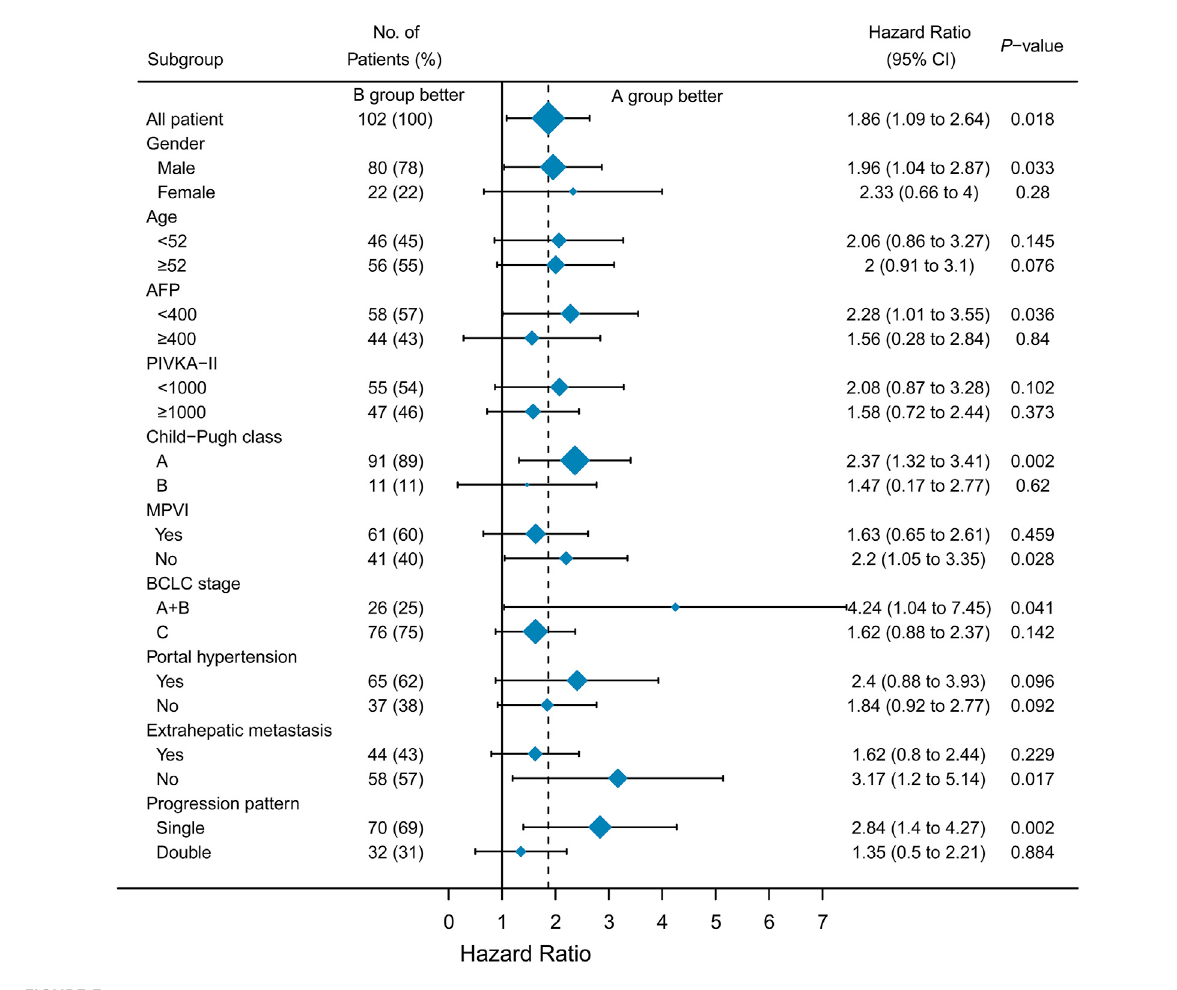
FIGURE 3 Subgroup analysis of second progression-free survival. MPVI, macroscopic portal vein